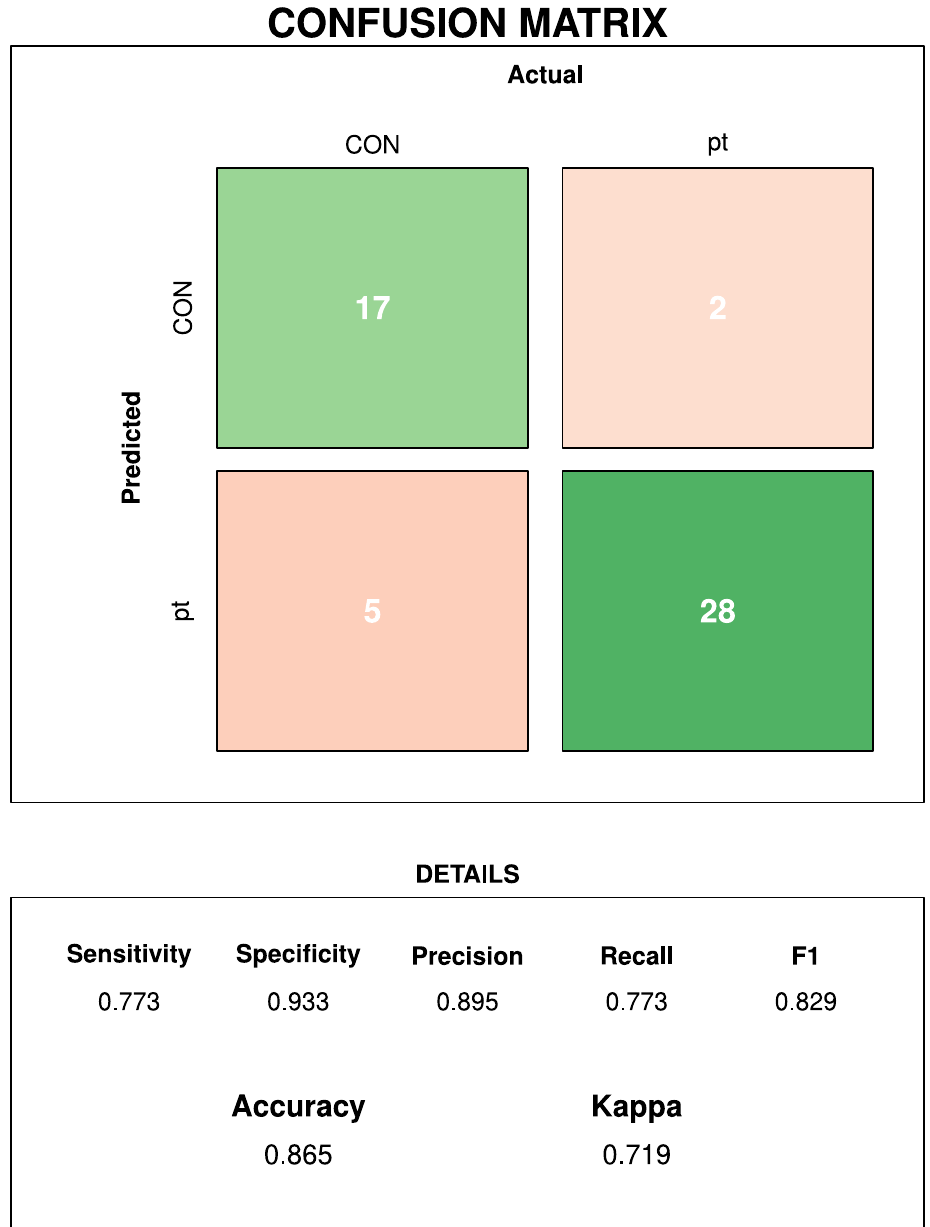
Figure 5. Confusion matrix showing the meta-classifier results for the testing